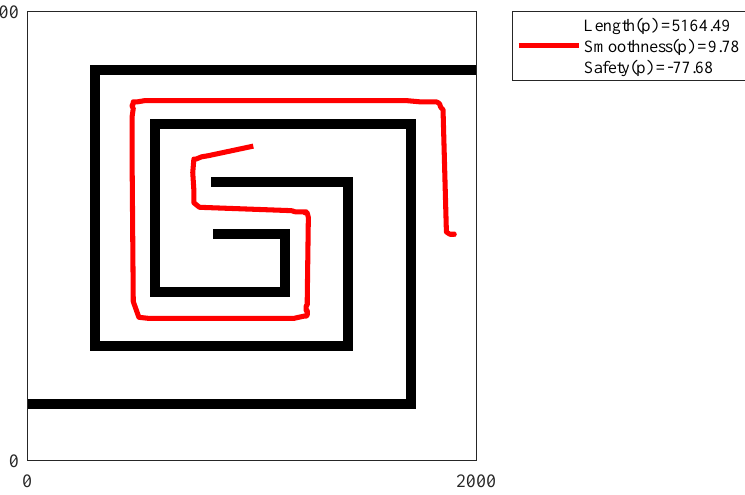
Figure 30. Path of the knee point generated via NSGA-II for Figure 11C.